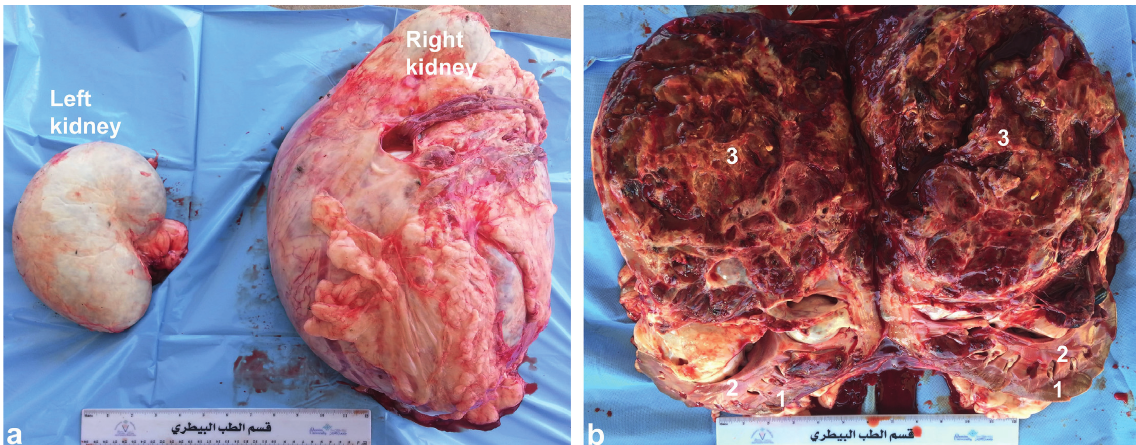
Figure 20: Postmortem findings in a female camel with renal cell carcinoma. Image (a) shows 18Kg right kidney compared to 1.5 Kg left kidney. Image (b) shows cross section through the right kidney large, hemorrhagic, irregular shaped, and cavitated tumor [29]. 1, cortex; 2, medulla; 3, tumor mass.